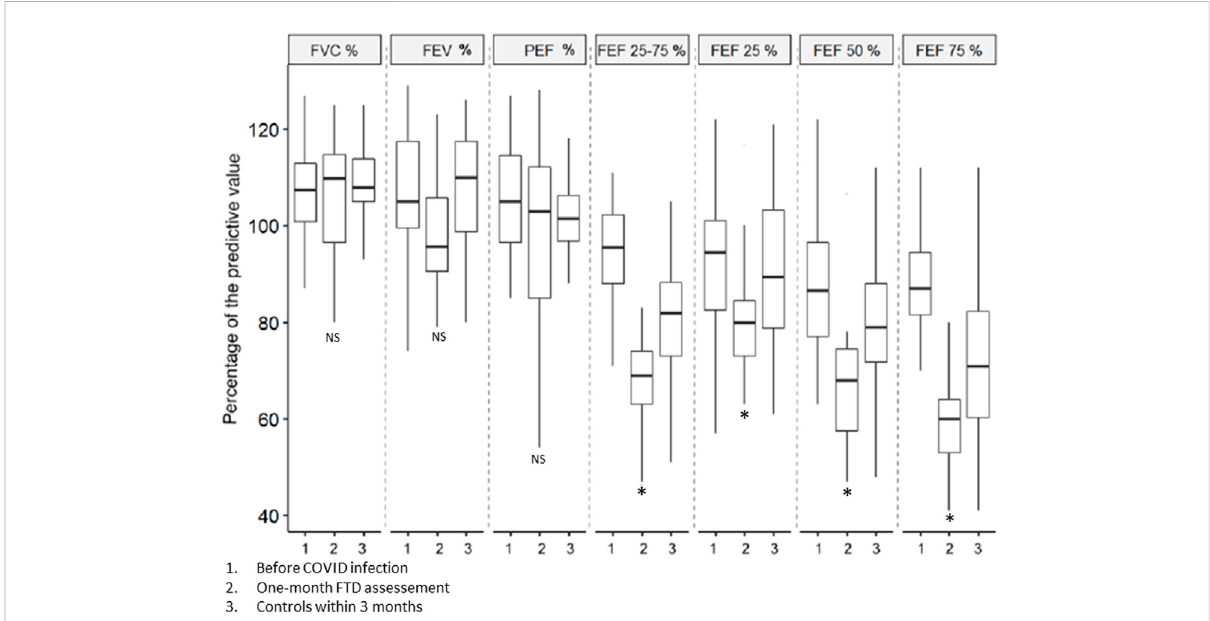
FIGURE 1 Evolution of spirometry values for the 20 subjects who had abnormalities on the post-COVID FTD assessment. The fi gure shows the baseline mean values (1), the values during the FTD assessment at 1 month (2) and the control performed within 3 months (3). Error bars represent standard error of the mean. * represents a signi fi cant difference from baseline values.